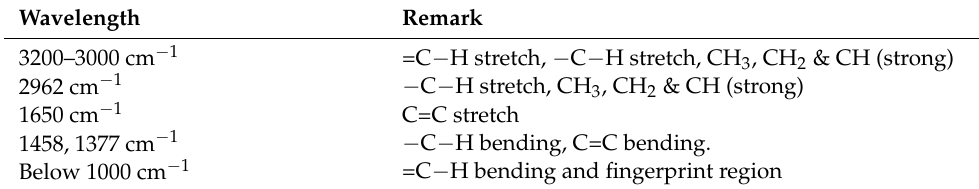
Figure 3. Fourier transformed Infrared spectra of plastic feedstock. Table 2. Summary of functional group analysis of plastic feedstock.